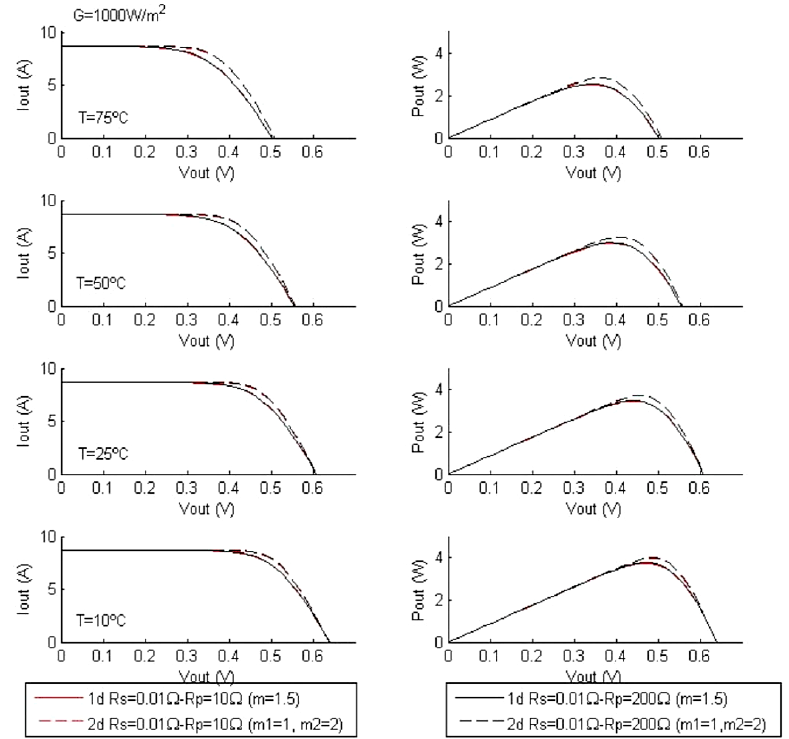
Figure 11. Characteristic curves of equivalent circuits of one and two diodes in function of temperature and parallel resistance R p , with a constant resistance R s (G = 1000 W/m 2 ).